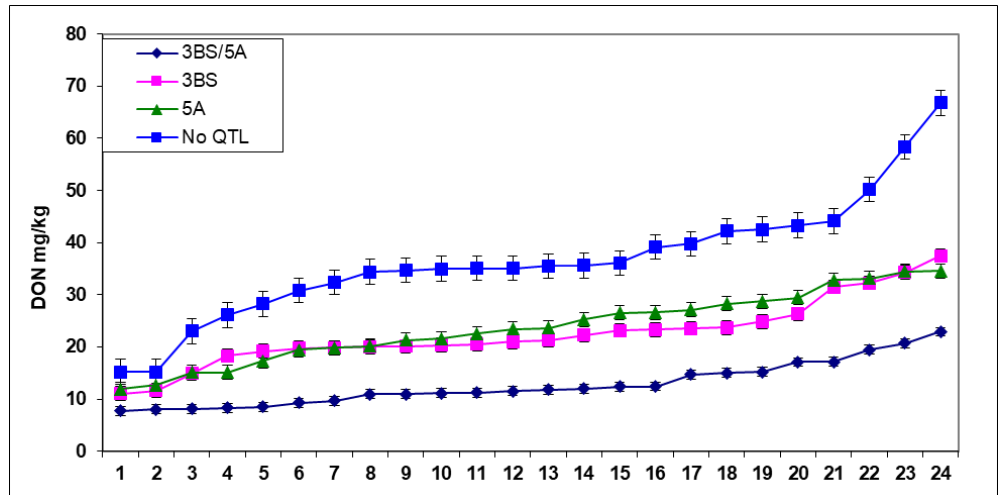
Figure 8. DON content (mg/kg) in the CM82036/Remus population across years, locations, and F. graminearum and F. culmorum isolates, 2002–2003. LSD 5% for genotypes 3.37, for QTL groups 2.16 [53].